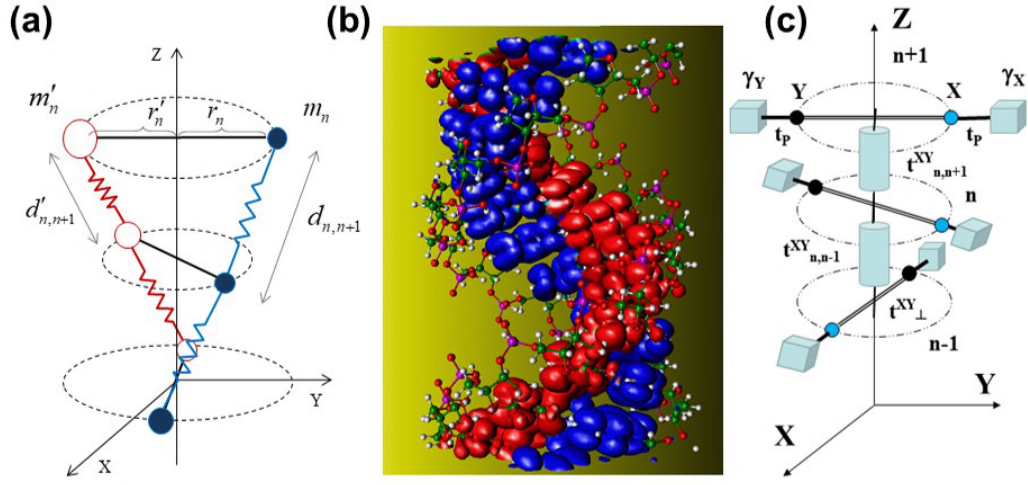
Figure 1. ( a ) Diagram of the dsDNA lattice model showing the harmonic bonds between adjacent bps through the sugar-phosphate backbone (zig-zag lines) and between complementary bases due to H-bonds (solid lines). ( b ) Full-atom dsDNA model with surfaces of constant charge density for the states corresponding to the π -like lowest unoccupied molecular orbital (LUMO, in red) of the C bases and the highest occupied molecular orbital (HOMO, in blue) of the G bases of a polyG-polyC molecule in the dry conditions A form (Courtesy of Emilio Artacho) [23]. ( c ) Diagram of the dsDNA electronic model showing the π - π channel transfer integrals t XY (cylindrical rods), the interstrand transfer integrals ⊥ 1 n , n between complementary bases t XY (perpendicular bars), the glucosidic transfer integrals t P between nucleobases (spheres) and sugar-phosphate groups (cubes), and the on-site energies of these groups γ j